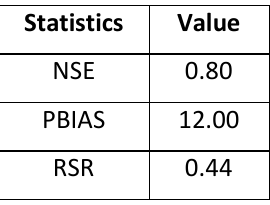
Table 2 - Model evaluation of BalanceMED. Three metrics were calculated to validate (range =−∞/+∞, optimum 0); and RMSE-observations standard deviation ratio (RSR)(range =0/+∞, optimum